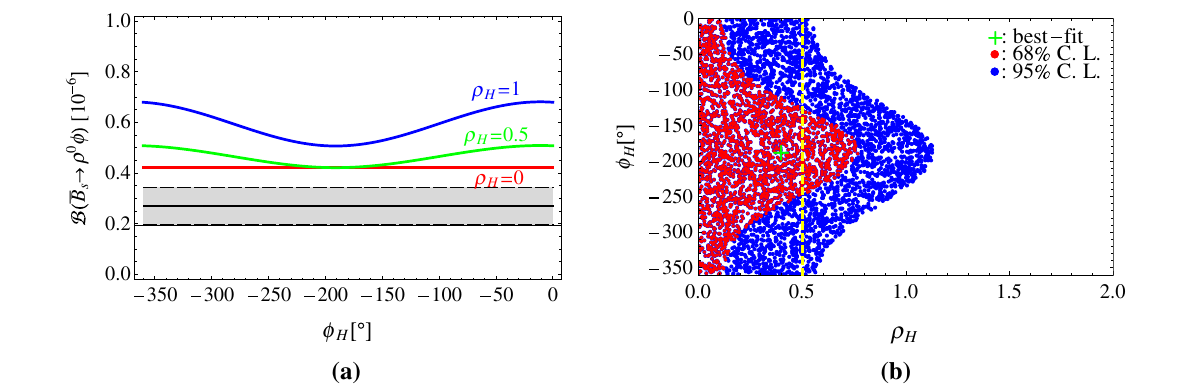
Fig. 1 a is the dependence of B ( ¯ B s → ρ 0 φ) on φ H with different ρ H labeled in the figure; the gray band is the experimental data within 1 σ error bars b is the allowed spaces of (ρ H ,φ H ) at 68% C.L. and